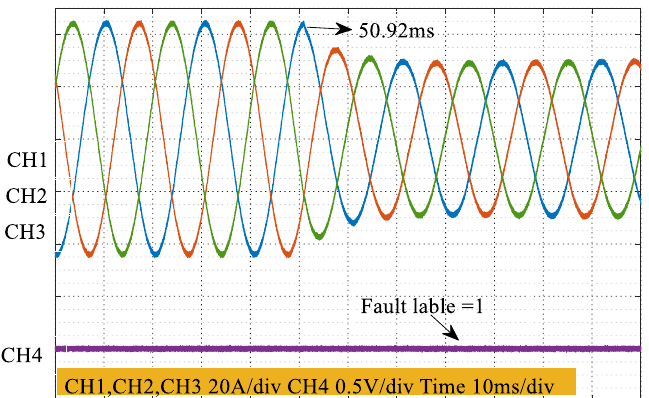
Figure 8. Transient sensitivity analysis of fault diagnosis, when the output current of the converter is regulated from 44 A to 36 A.